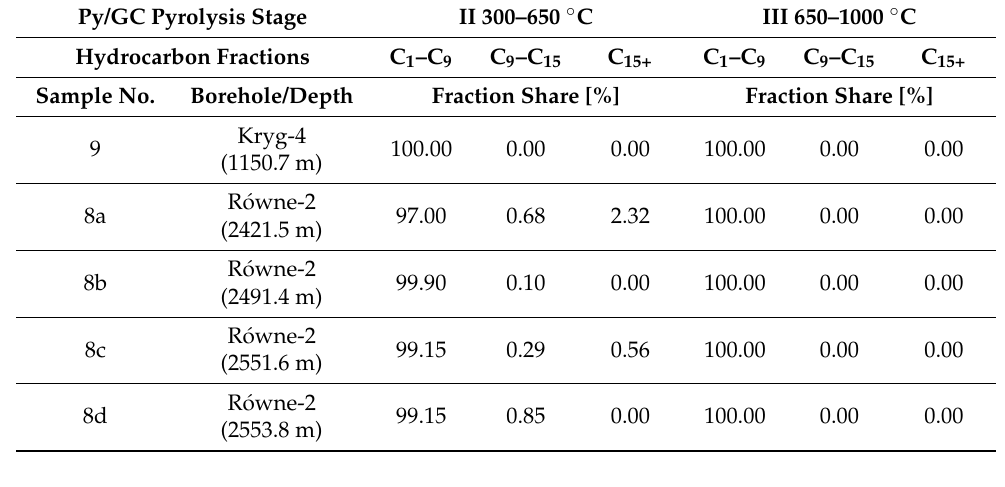
Table 7. Results of Py/GC analysis of core samples from Istebna Beds.